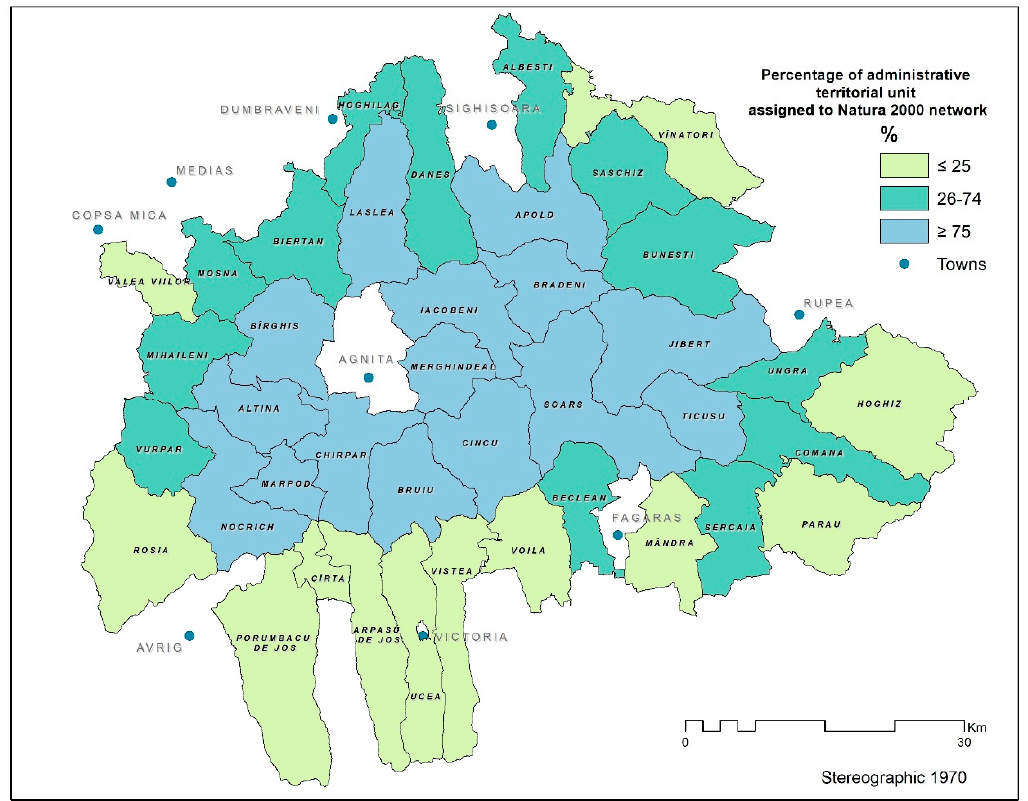
Figure 2. Percentage of rural administrative territorial units assigned to Natura 2000 sites. Table 2. The profile of communities living in protected areas compared to the available